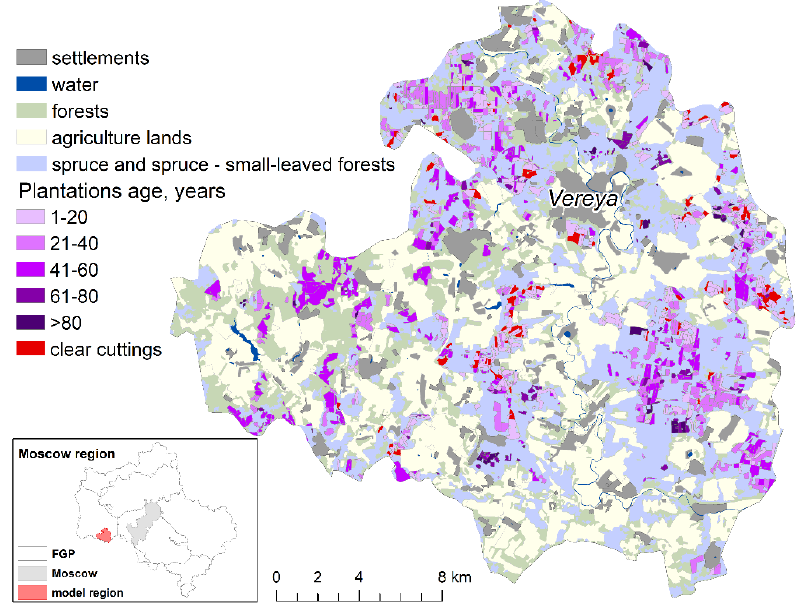
Figure 10. Main patterns of land cover and forests of various origins for the test plot.